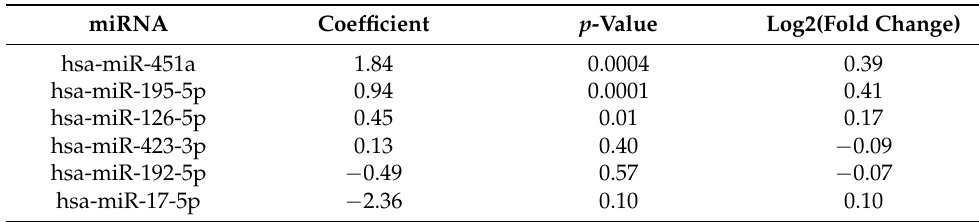
Table 2. Optimal miRNA biomarker